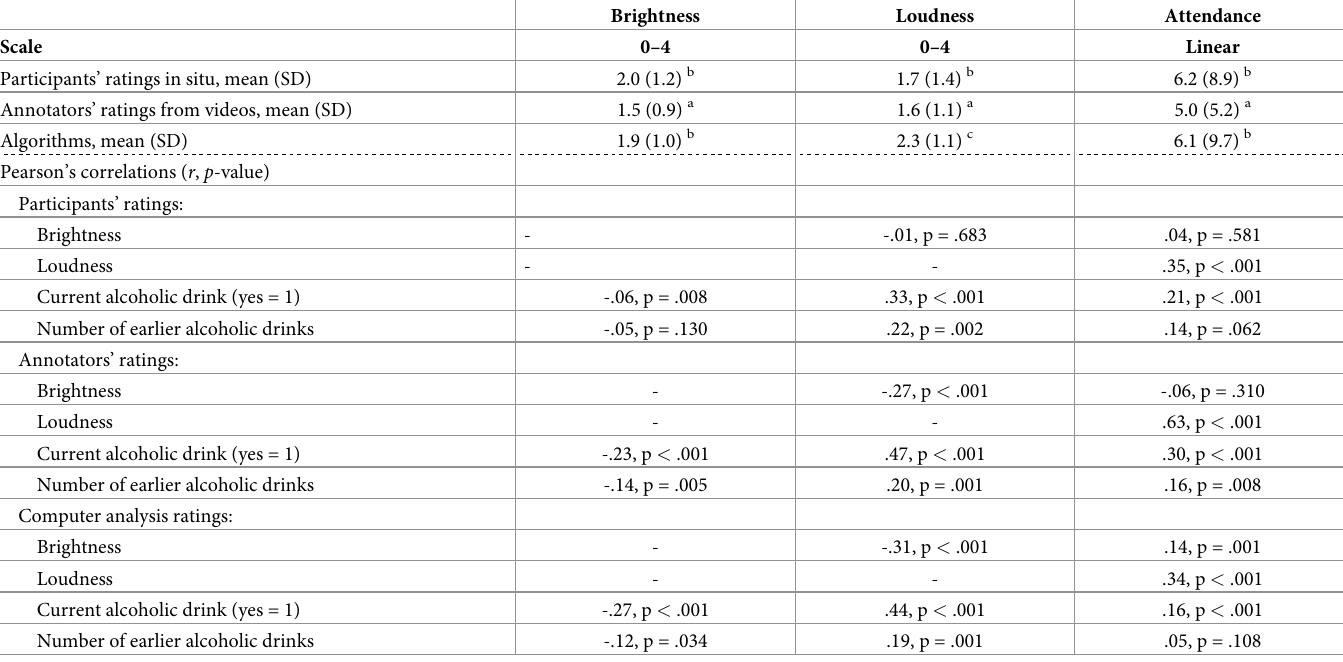
Table 1. Average ratings of brightness, loudness and number of people per data source, and bivariate correlations with drinking behaviors and participants’ demographics. Brightness Loudness Attendance 0–4